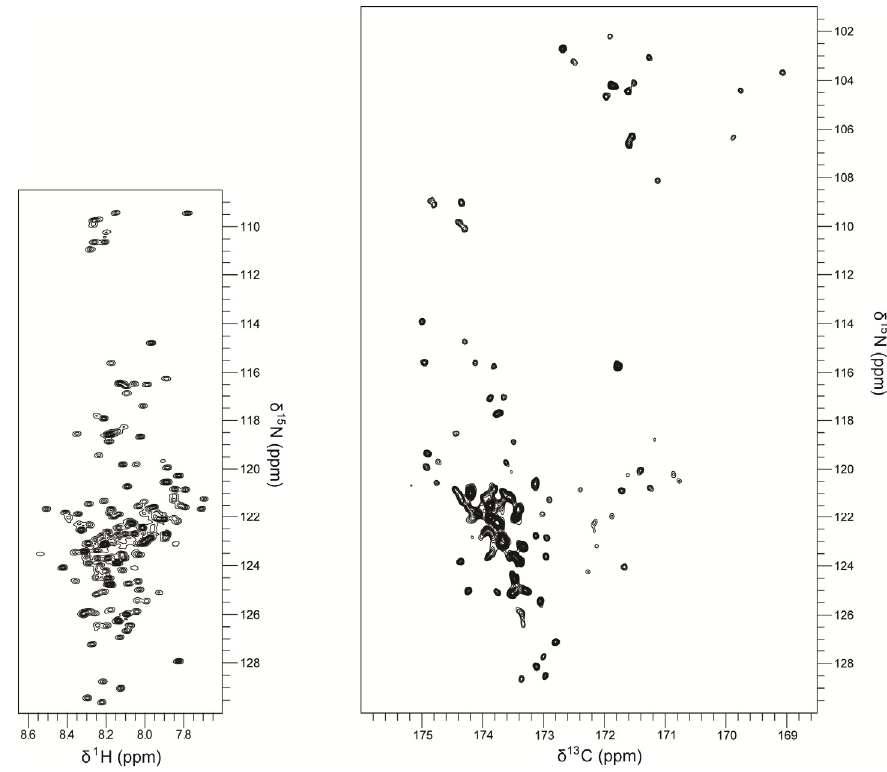
Figure 1. TROSY- 15 N-HSQC (left) and CON (right) spectra of the fully disordered